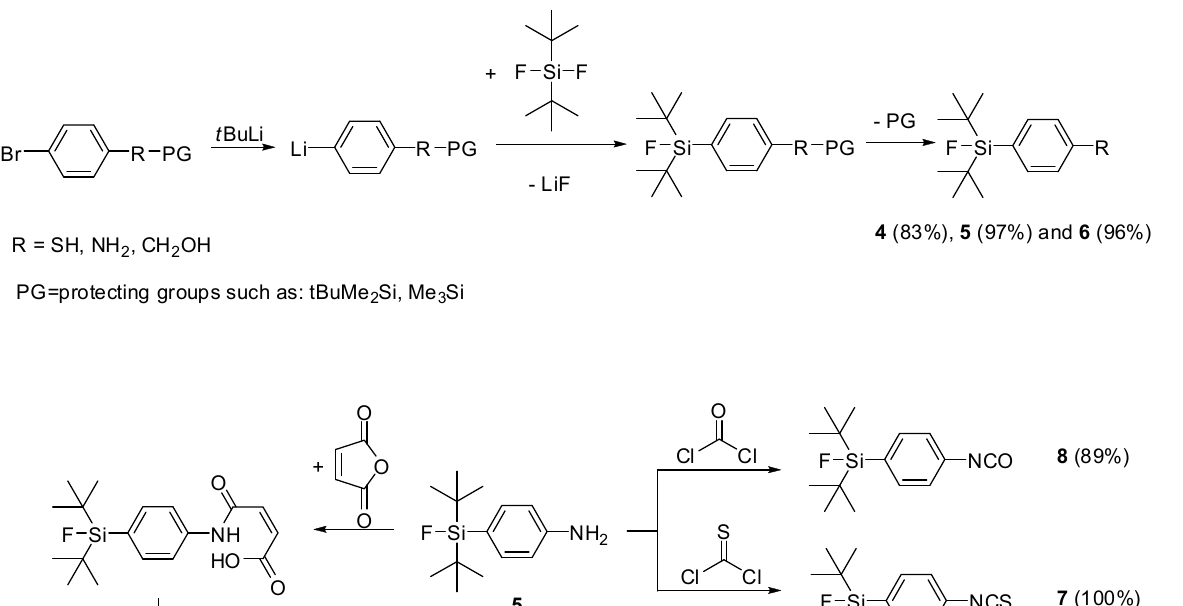
Figure 4 . Syntheses of various small SiFA building blocks intended for